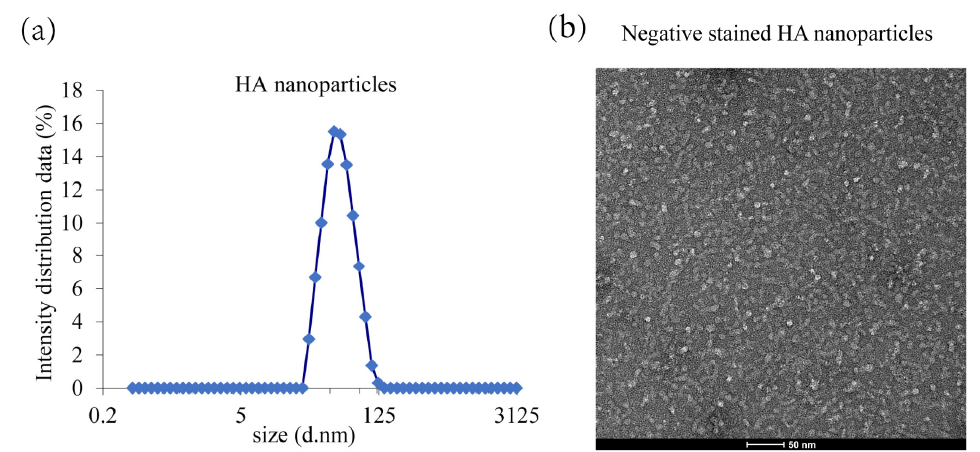
Figure 2. Dynamic light scattering (DLS) and transmission electron microscopy (TEM) analysis of HA nanoparticle. ( a ) DLS analysis of HA nanoparticle. ( b ) TEM analysis of HA nanoparticle.